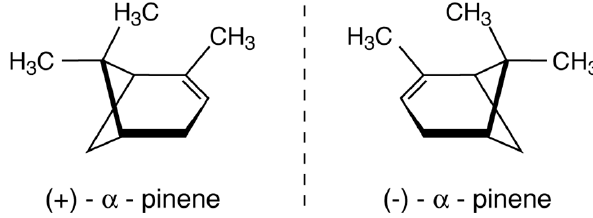
Fig. 1. Mirror image of α -pinene